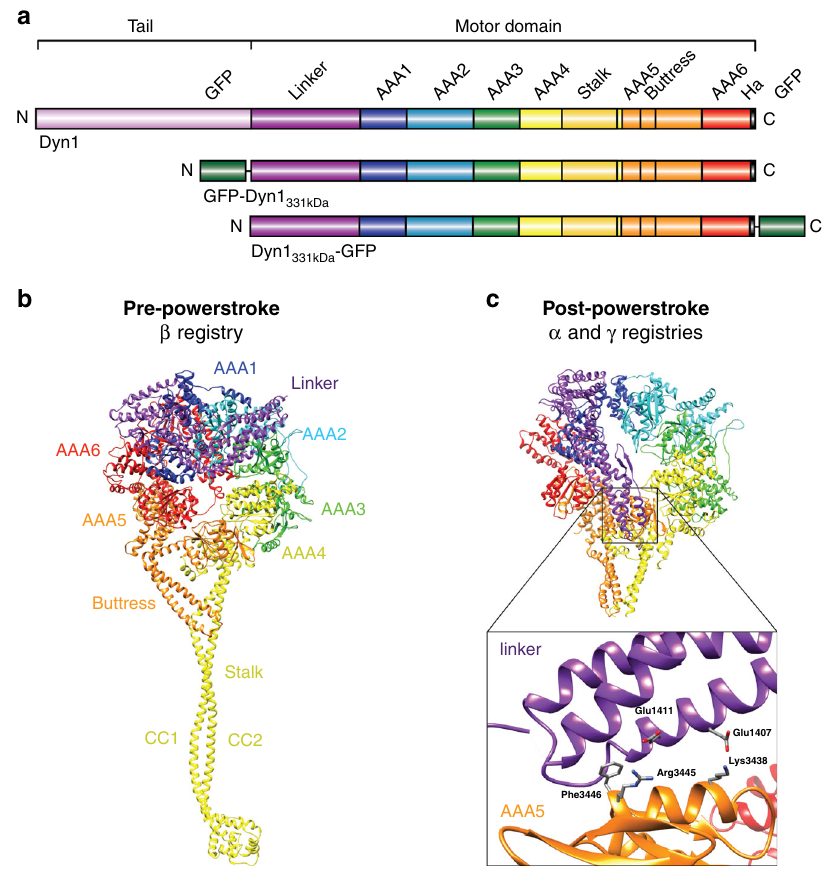
Fig. 1 Cytoplasmic dynein domain organization and pre-powerstroke and post-powerstroke states in relation to the stalk-helix registrations of the dynein motor domain (MD). a Organization of the full-length cytoplasmic dynein heavy chain (HC) (a.a. 1 – 4092) and the tail-truncated monomeric constructs, GFP-Dyn1 331kDa and Dyn1 331kDa -GFP (a.a. 1219 – 4092). b Dynein MD structure in the pre-powerstroke state (ADP.Vi, Homo sapiens cytoplasmic dynein-2; PDB entry 4RH7 60 ). The linker is bent and close to AAA2 (left), and the stalk helices assume the weak microtubule (MT)-binding β registry as a result of the undocked linker 24 . c Post-powerstroke state (Apo, S. cerevisiae dynein; PDB entry 4W8F 62 ). The linker is straight and docked on AAA5, and the stalk helices assume the strong MT-binding α registry or the γ registry with intermediate MT-binding strength. Interactions between hydrophobic linker residues (E1407 and E1411) and highly conserved AAA5 residues (F3446, R3445, and K3438) facilitate docking of the linker N-terminus on AAA5 62 (PDB entry 4W8F 63 )